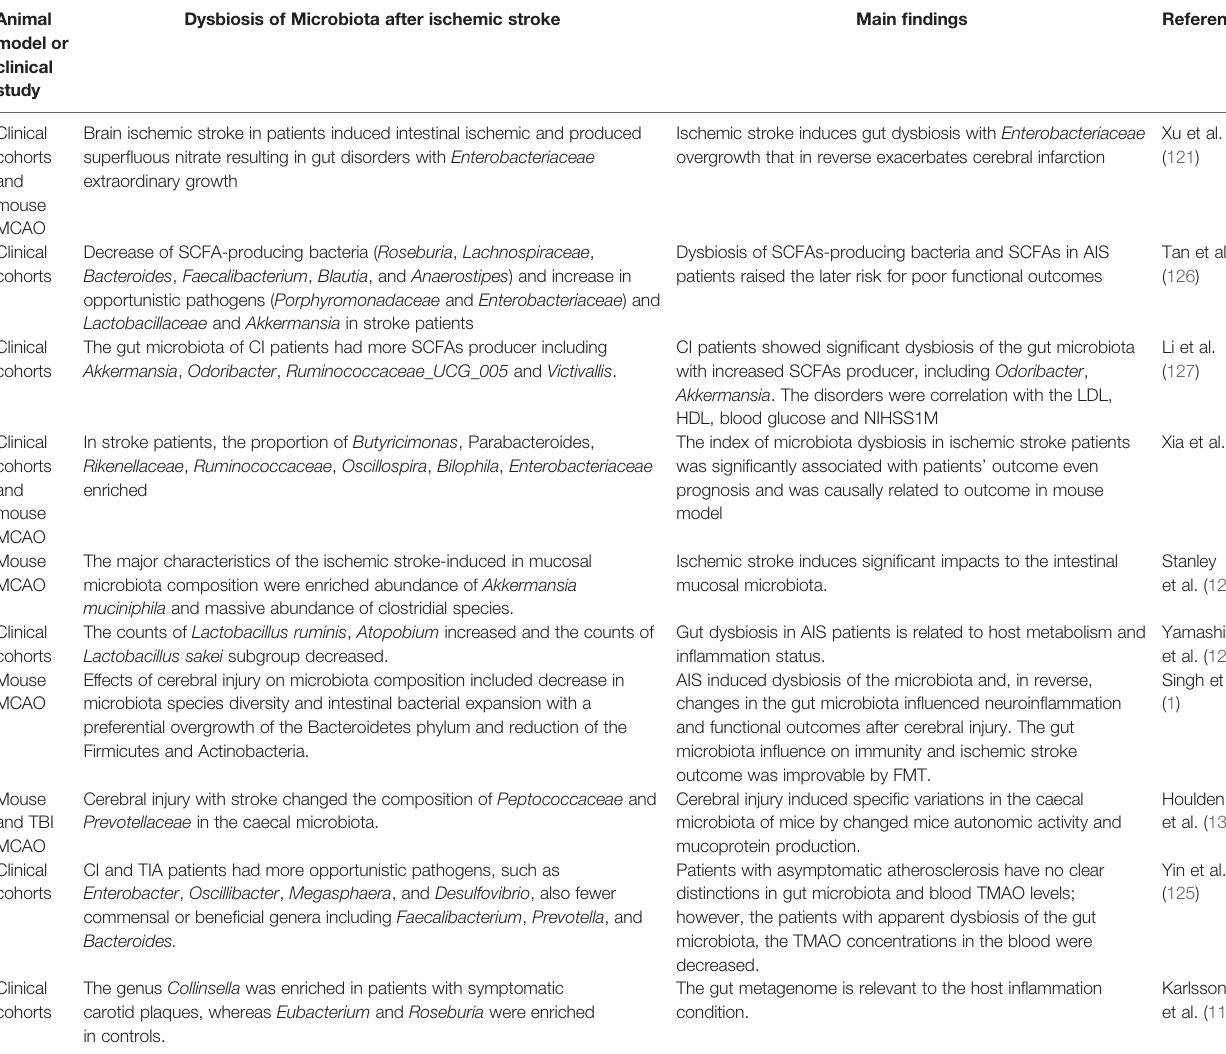
TABLE 1 | Changes in the gut microbiota composition after ischemic